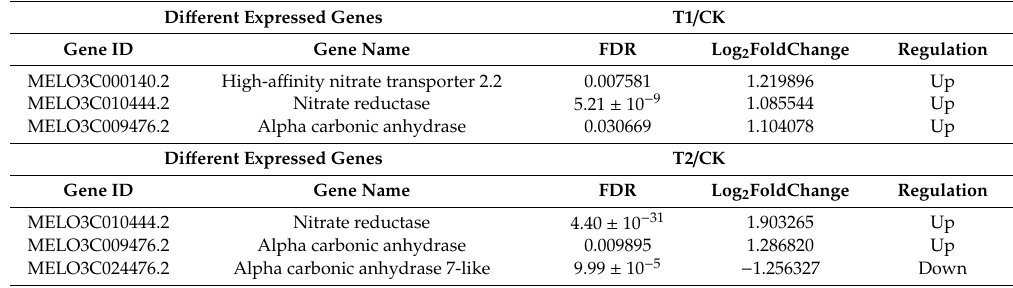
Table 3. Di ff erentially expressed genes (DEGs) annotated in nitrogen metabolism in T1 / CK and T2 / CK comparisons. Signification of DEGs was measured by the two criterions of | Log 2 FoldChange | ≥ 1 and FDR ≤ 0.05.